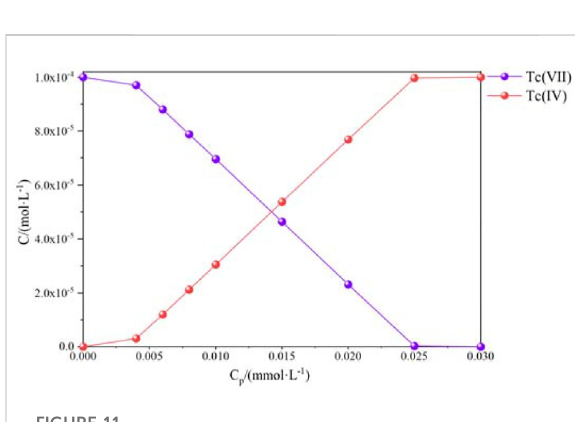
FIGURE 11 Concentration of Tc( Ⅶ ) and Tc( Ⅳ ) as a function of the pyrite